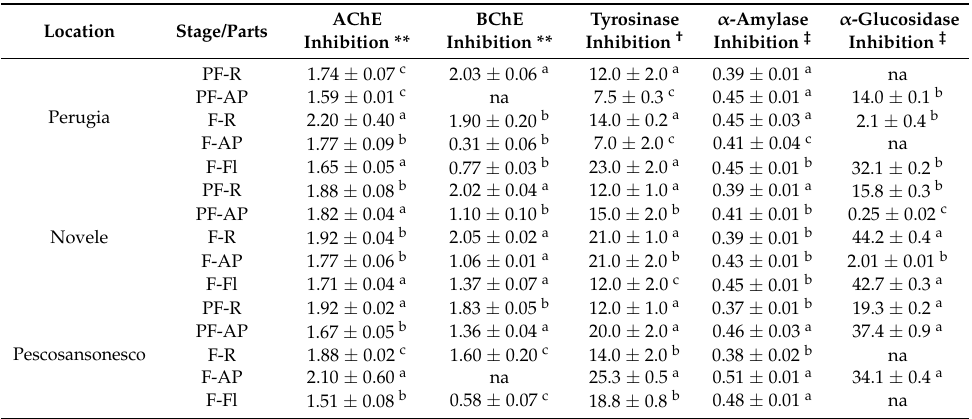
Table 6. Enzyme inhibitory effects of different parts of A. lutea collected from three different locations in Italy